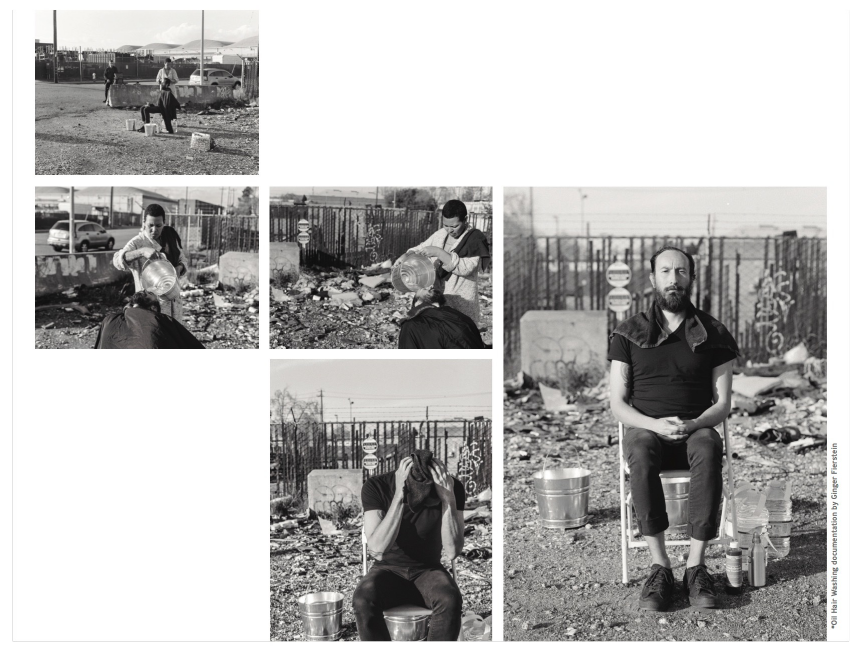
Figure 1: Crudoleum hair washing on March 25, 2017, at historic Station B, site of the first crude oil production in Oakland, California, in 1902. Shimeko Franklin washes Elia Vargas’s hair with Crudoleum as part of 100 Days Action , 2017. Image from self-published speculative exhibition catalogue of Vargas’s solo exhibition, Lubricated Substrates at B4BEL4B gallery, Oakland, California. Catalogue designed by Sming Sming Books. Photos: Ginger Fierstein. Reproduced with